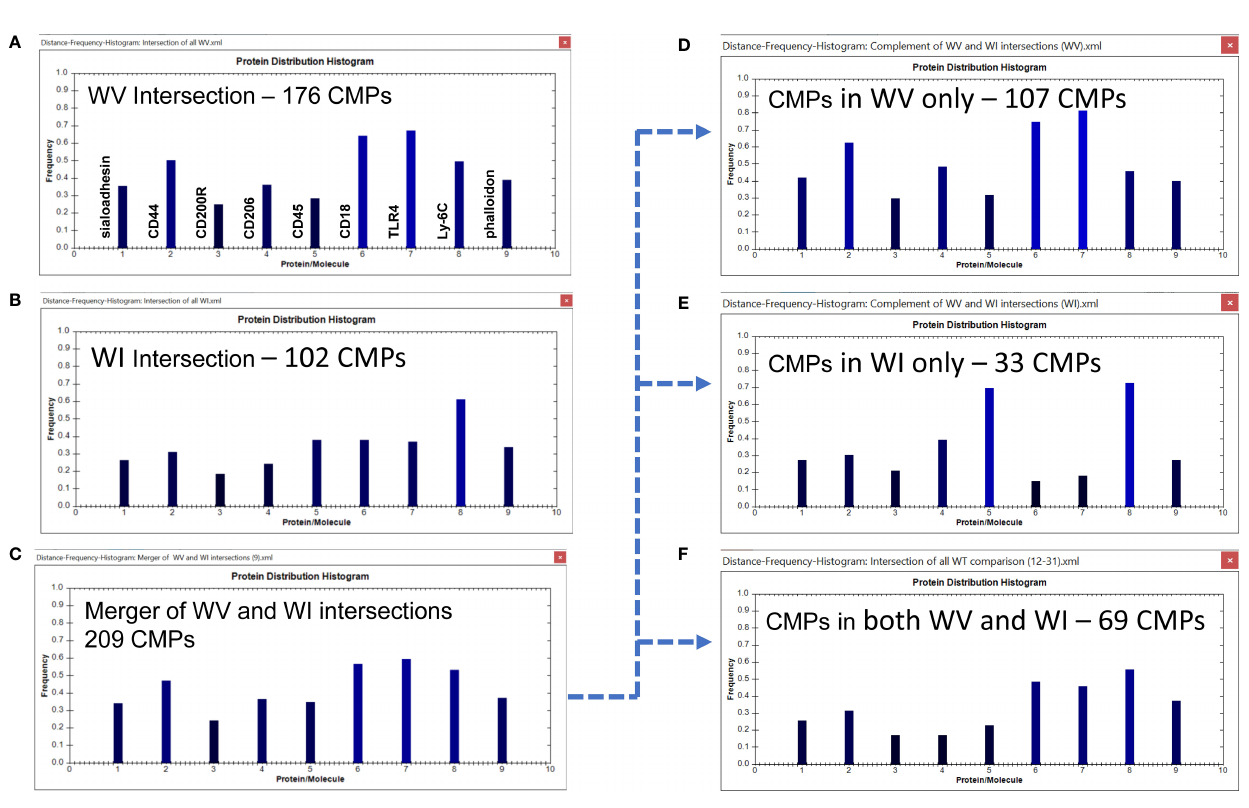
FIGURE 6 | CMP comparison of wild type AM with nine markers. The names of the proteins represented by each histogram bar are shown in Panel (A) . The same order applies to all other histogram panels in this and subsequent fi gures. Panels (A, B) show the intersection of the three wild type vehicle and three wild type infected samples. The intersection feature identi fi es the “ conserved ” CMPs present in all three samples of each group. Panel (C) depicts the merged results of Panels (A, B) and shows the characteristics of the 209 CMPs that are conserved in the vehicle and/or infected groups. Panels (D – F) use the complement feature of the TIS software to identify from the merged 209 CMPs, CMPs present in vehicle AM only (D) , infected AM only (E) , or common to both groups (F) . The arrow originating at Panel (C) and terminating at Panels (D – F) illustrates this